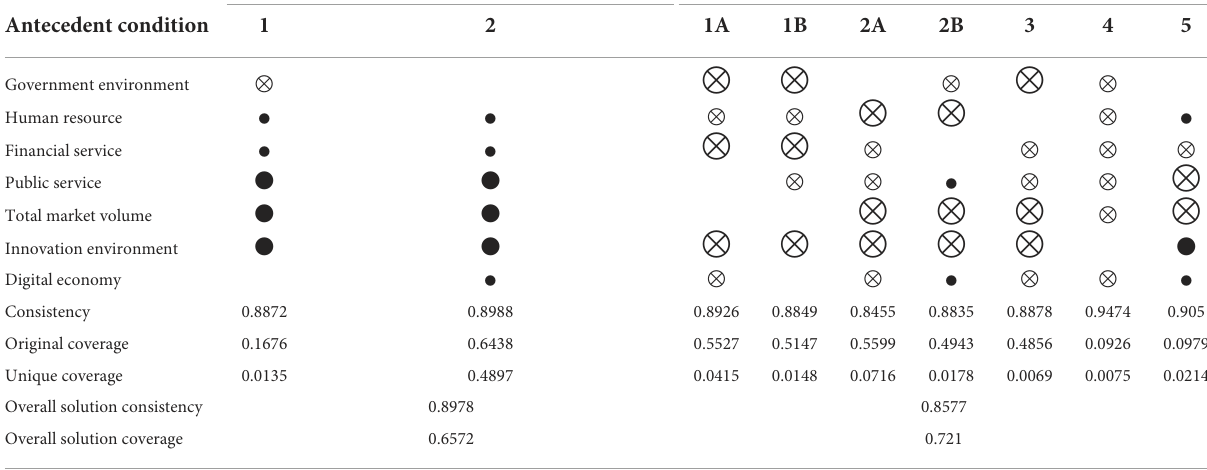
TABLE 7 Robustness